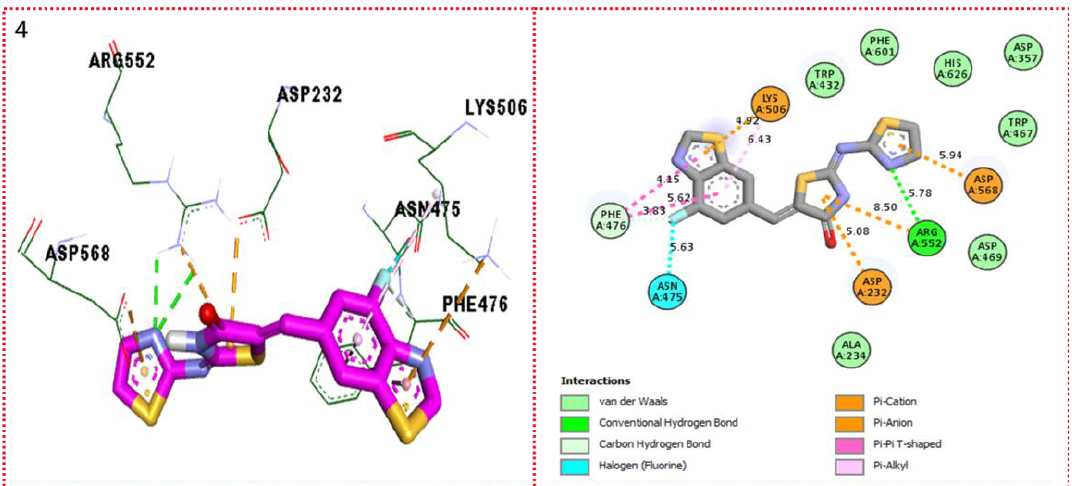
Figure 8. Protein–ligand interaction profile for active analogue against α -glucosidase represents the surface of the corresponding enzyme and indicates the PLI profile for compound 4 .